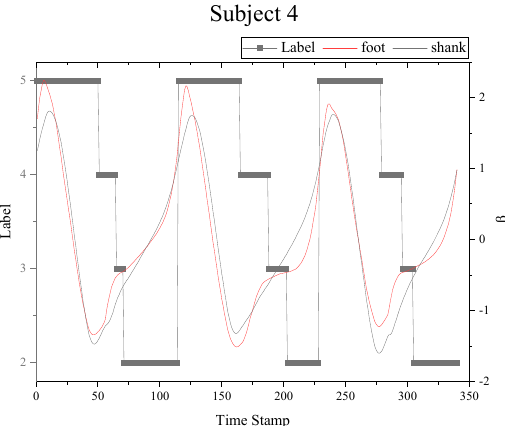
Figure A5. Pitch angles of foot and shank of subject 4.